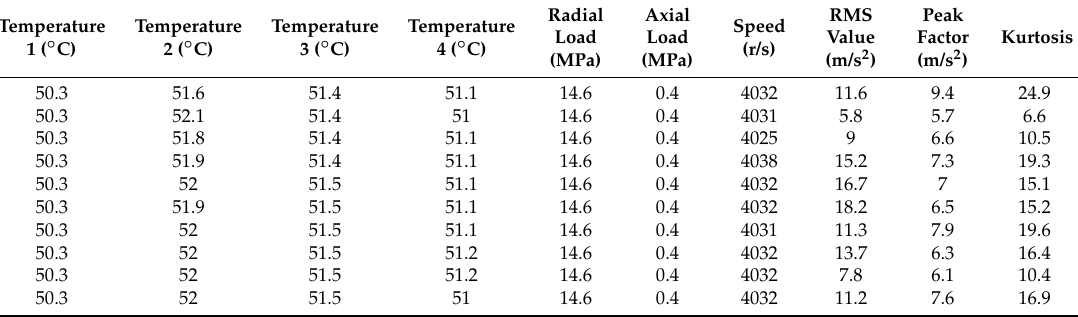
Table 6. Partial data of the test machine status during serious wear of bearings.